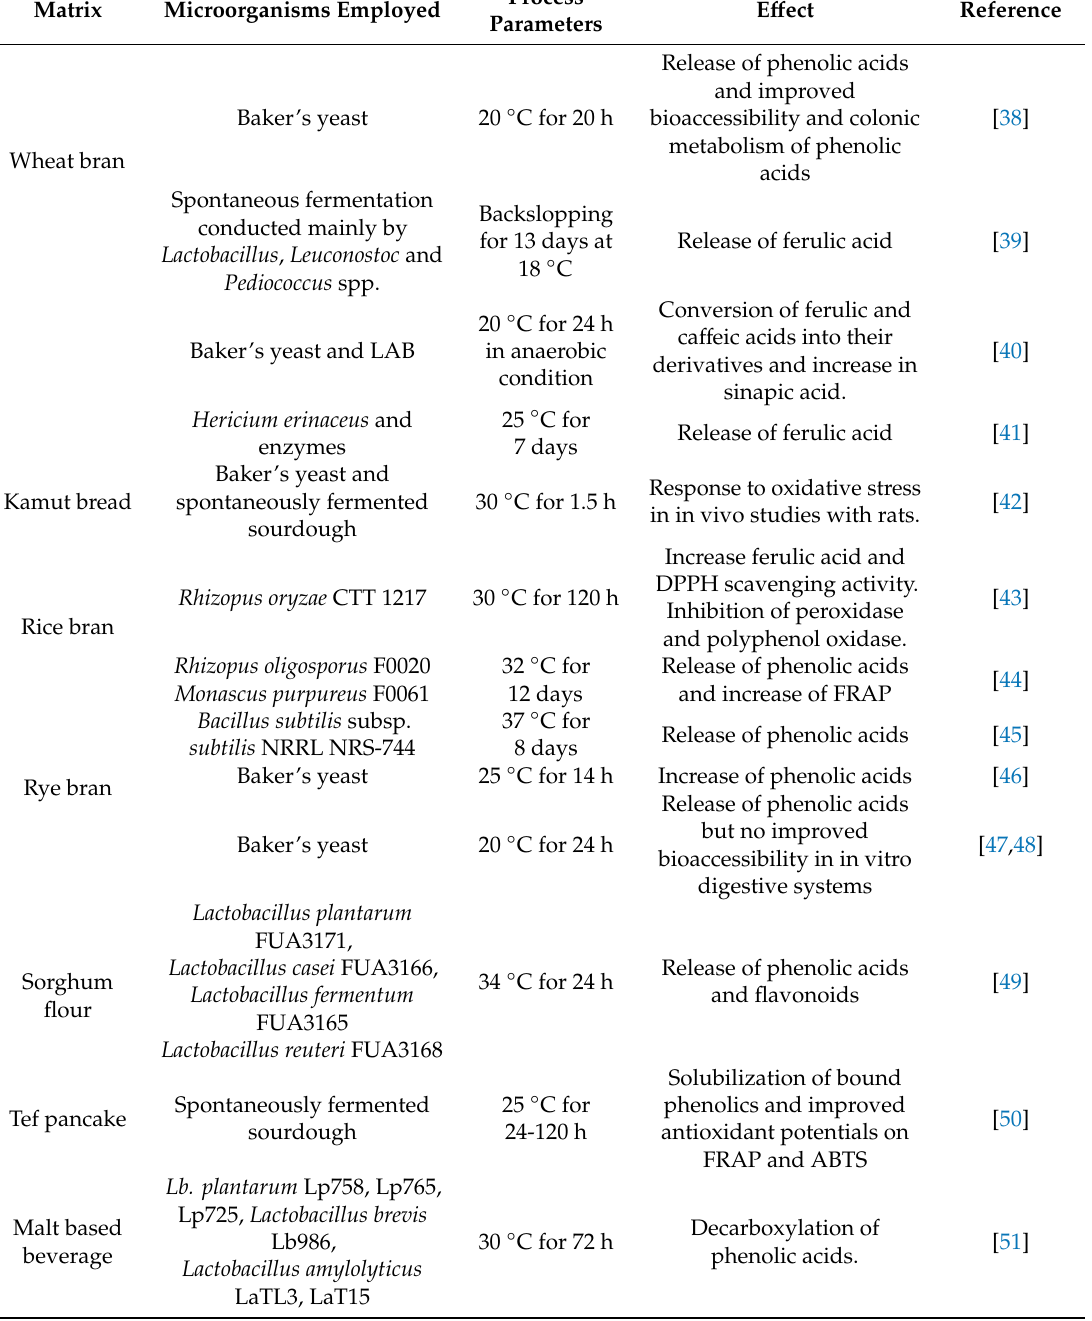
Table 1. Main e ff ect of polyphenols metabolism on the antioxidant activity of fermented cereals and